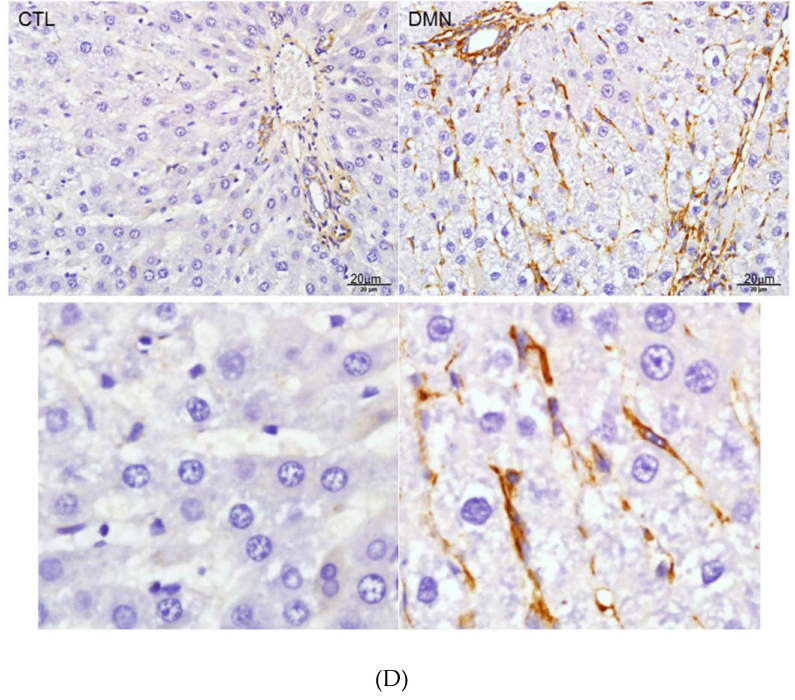
Figure 1. ( A ) Histologic examination of rat liver at zero week (0W), two weeks (2W), and four weeks (4W). Upper panels: Hematoxylin–eosin (H / E) staining indicated necrosis of hepatocytes and infiltrated lymphocytes. Lower panels: Masson’s trichrome staining of rat liver tissues. The images indicated accumulation of collagen around portal tracts as blue images. ( B ) Validation of α -smooth muscle actin ( α -SMA), vimentin, collagen type III (Col III), and collagen type I (Col I) expression by RT-PCR after treatment of dimethylnitrosamine (DMN). β -Actin was used as an internal control. The quantified results were indicated by the bar chart and represent the mean ± SD of three independent experiments (* p < 0.05, ** p < 0.01, *** p < 0.001, ns: no significance). ( C ) Confirmation of change in extracellular matrix (ECM) protein level after DMN application. Protein expression of α -SMA, vimentin, and Col I was assessed by a Western blot analysis. Glyceraldehyde-3-phosphate dehydrogenase (GAPDH) was used as an internal control. Polyvinylidene difluoride (PVDF) membrane stained with Coomassie blue R-250 was utilized to perform loading amount of proteins. The quantified results were presented by the bar chart (* p < 0.05, *** p < 0.001, ns: no significance.). The results are representative of the